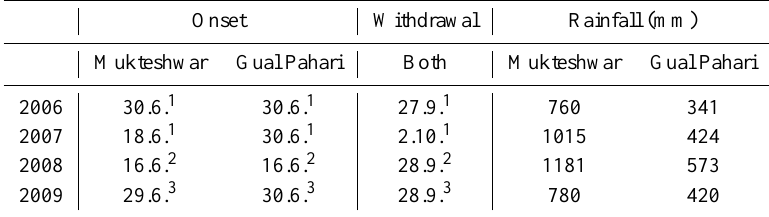
Table 1. Onset/withdrawal dates of monsoon in Mukteshwar and Gual Pahari. Total rainfall during the monsoon period, calculated from monthly data between June–September.